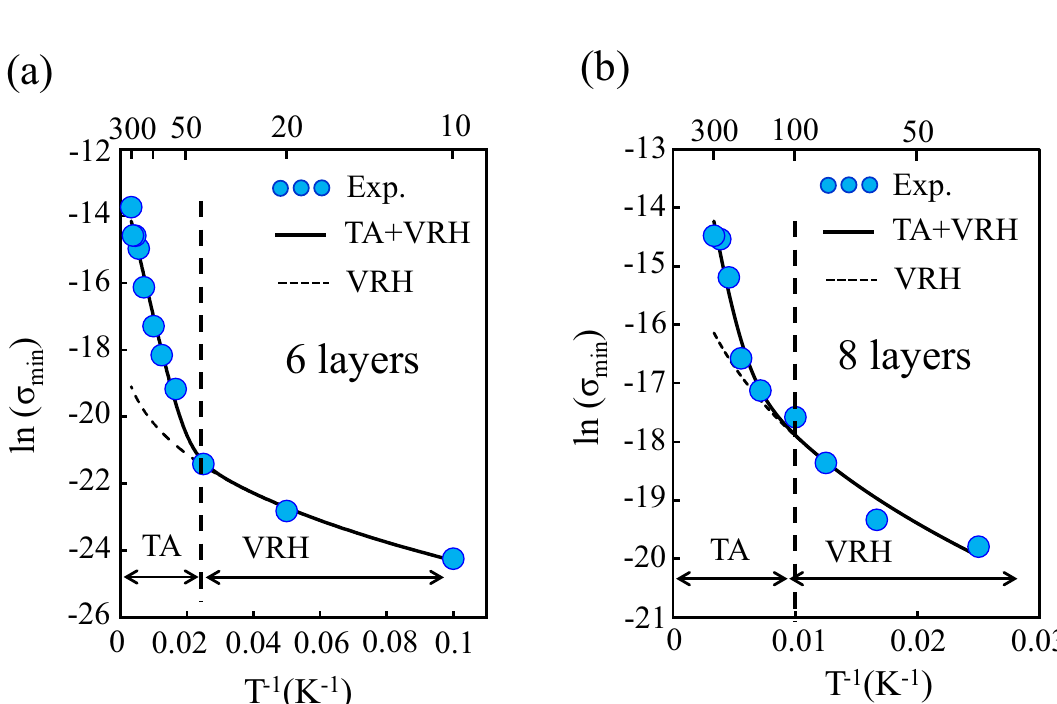
Figure 6. A plot of ln (σ min ) measured from the multilayer GNR with ( a ) 6 and ( b ) 8 layers vs T −1 , respectively. The circles and solid lines are experimental data and the fitting curves by the sum of the TA and 2D-VRH